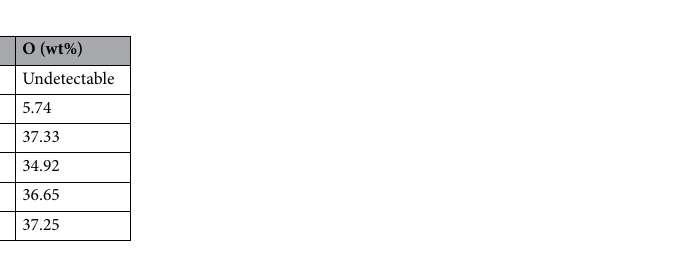
Table 1. EDS analysis of the untreated and heat-treated TiZr alloy specimens.